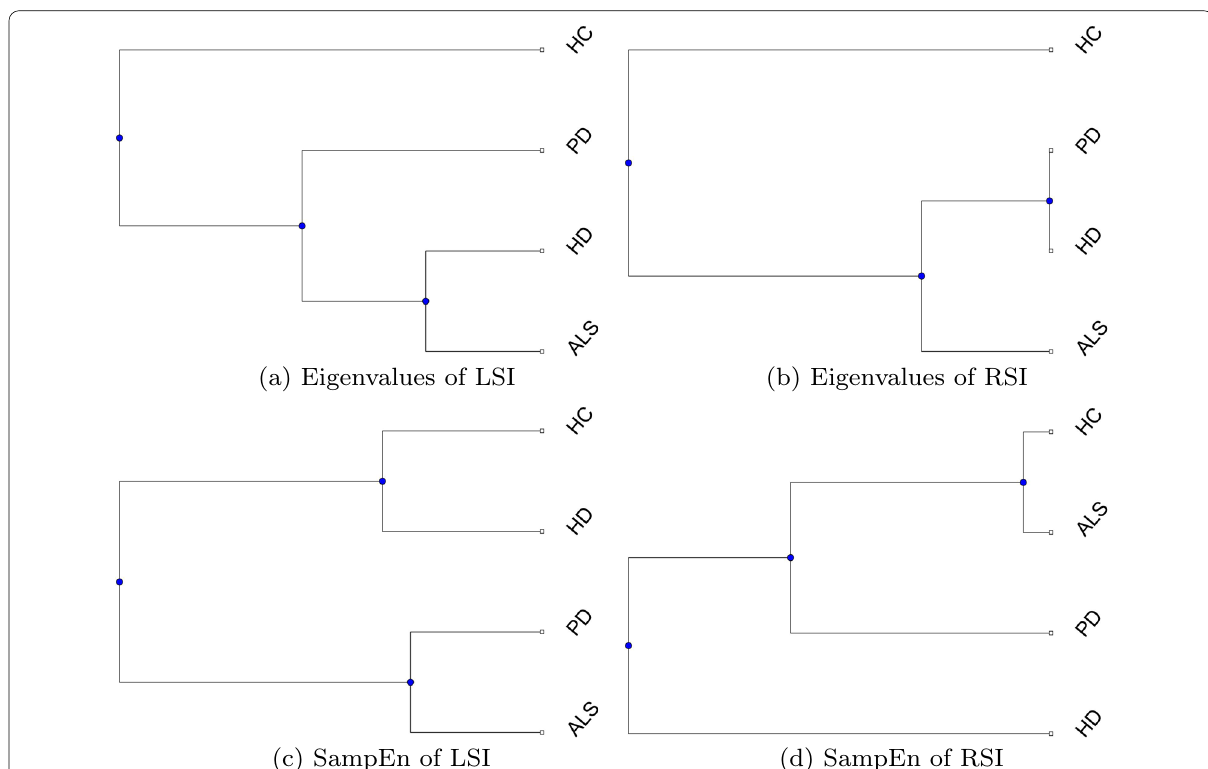
Fig. 5 Phylogenetic trees constructed with UPGMA using pairwise distances of left and right swing intervals obtained from methods of recurrence eigenvalues and